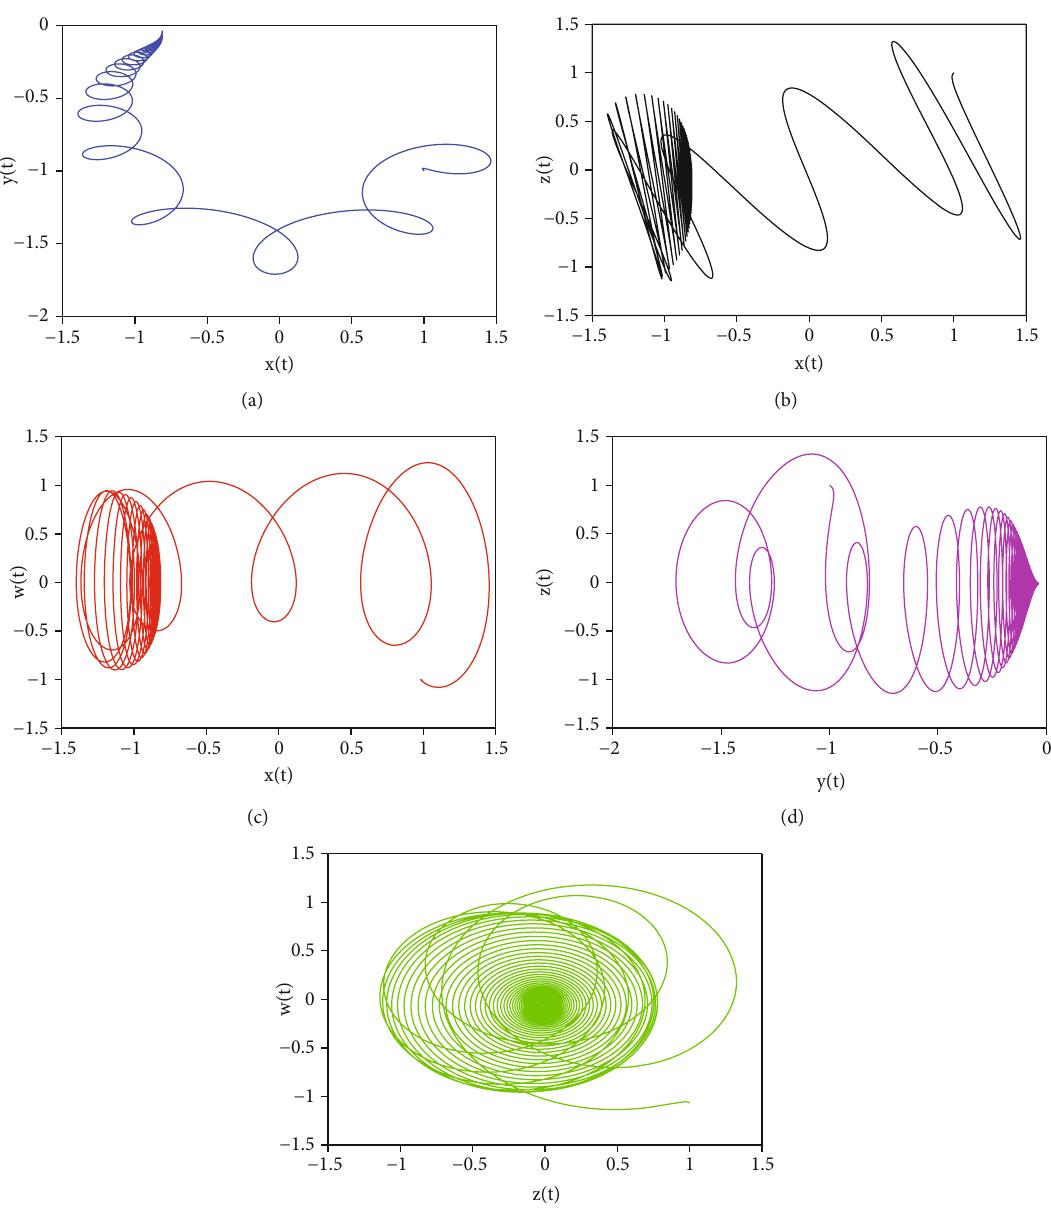
Figure 14: The behavior of di ff erent state variables of system 2 with fractional order ϖ = 0 : 99 and the parameters are considered as m = 2, n = 5